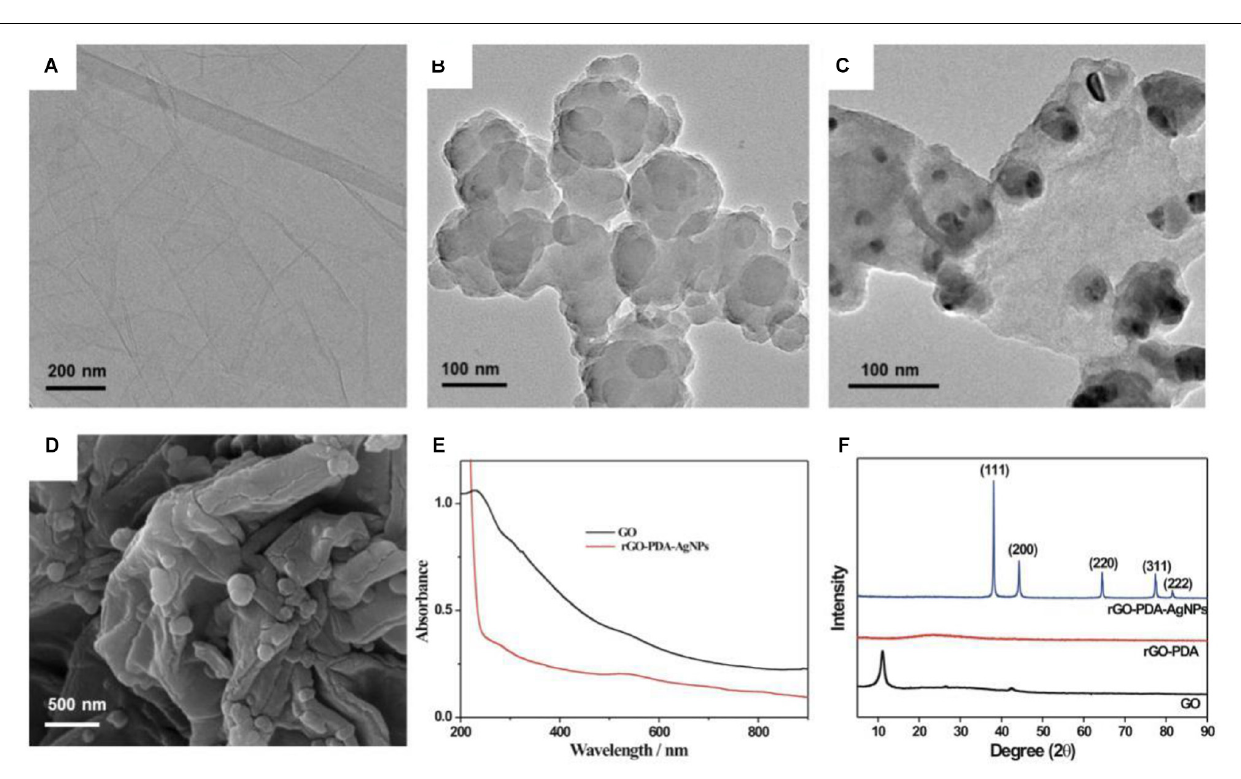
FIGURE 1 | TEM images for GO (A) , rGO-PDA (B) and rGO-PDA-AgNPs (C) . (D) SEM image for rGO-PDA-AgNPs. (E) UV-vis spectroscopy of GO (black) and rGO-PDA-AgNPs (red). (F) XRD patterns of GO (black), rGO-PDA (red) and rGO-PDA-AgNPs